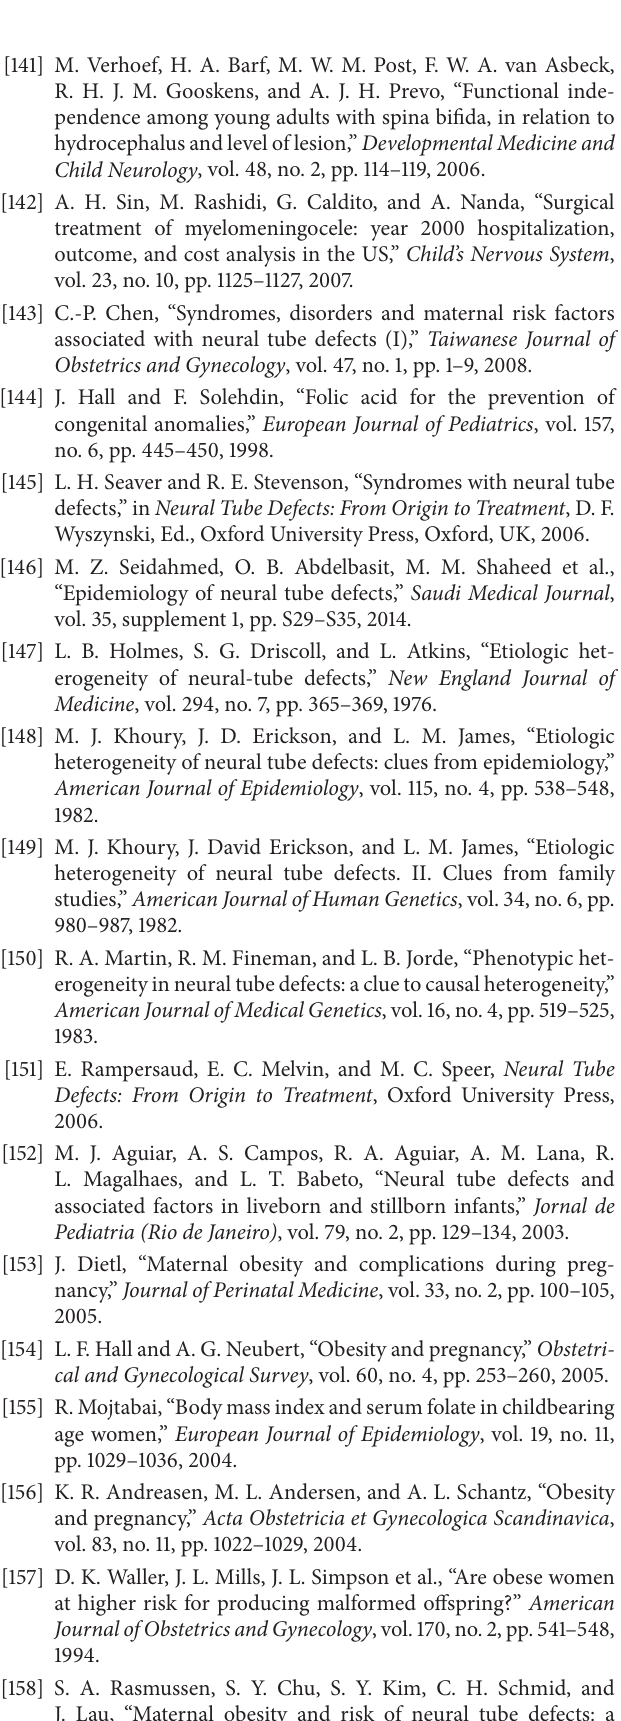
table angle: an anatomic, osteologic study of three thousand